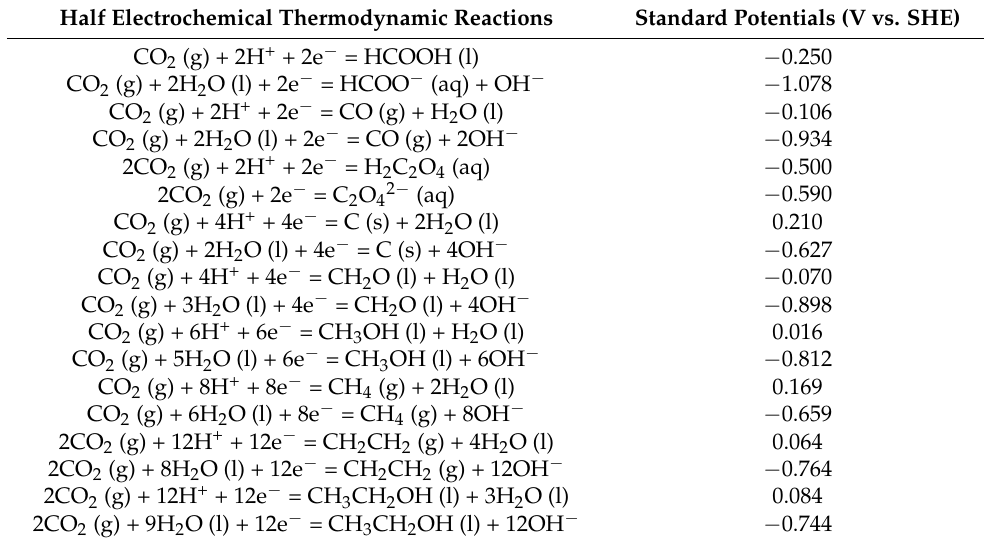
Table 1. The standard potential for the conversion of CO 2 to various C1 and C2 products in aqueous solution under standard conditions (1.0 atm and 25 ◦ C). Reprinted from Ref. [45], copyright (2014), with permission from the Royal Society of